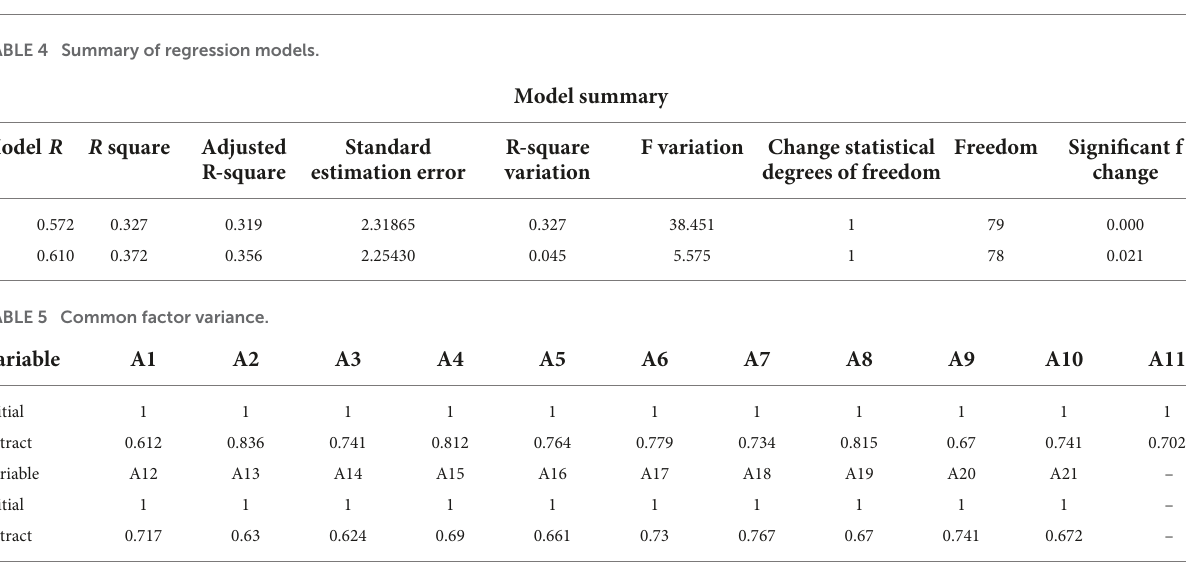
Table 6 is the total variance